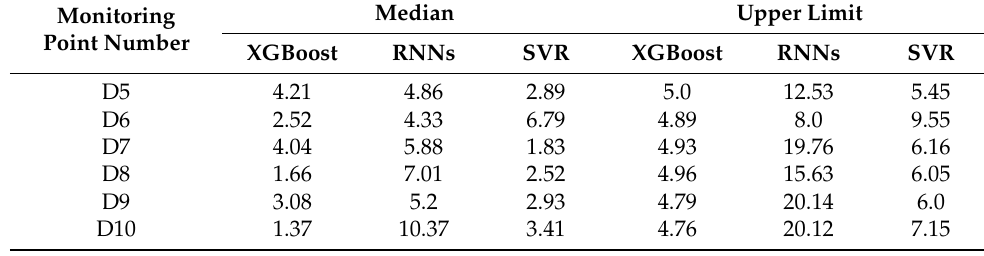
Table 1. Median of relative error and upper limit (%).